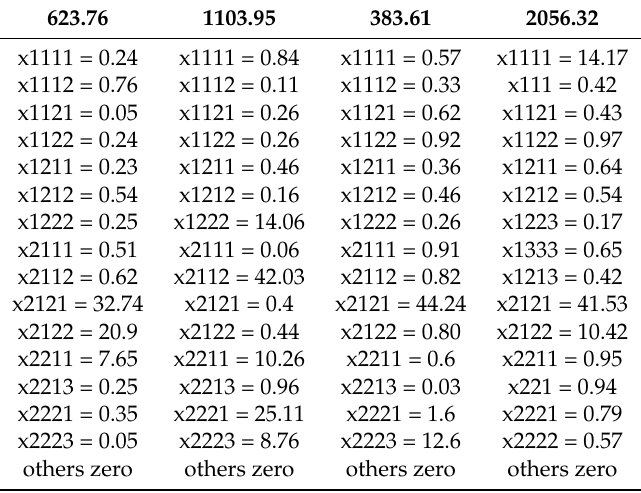
Table 10. Optimum results of the STP Model ignoring